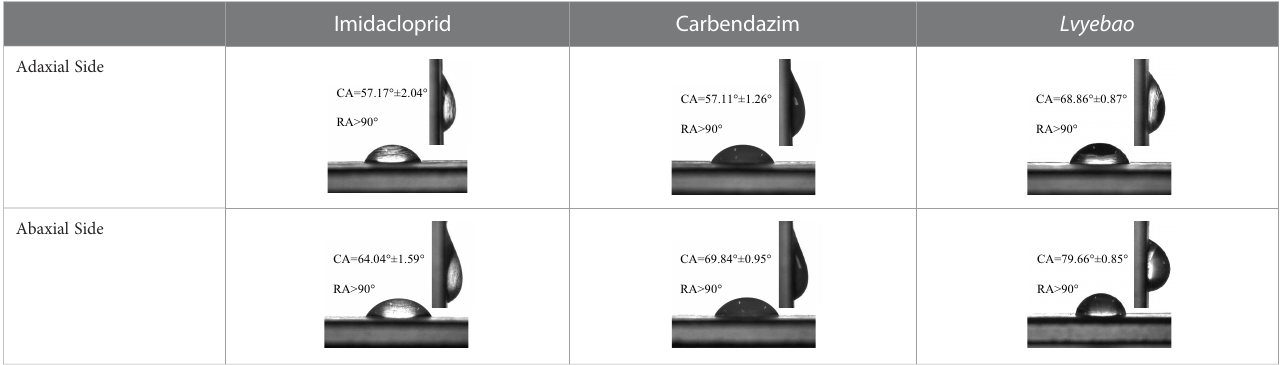
TABLE 2 Wettability of three pesticides on banana leaf